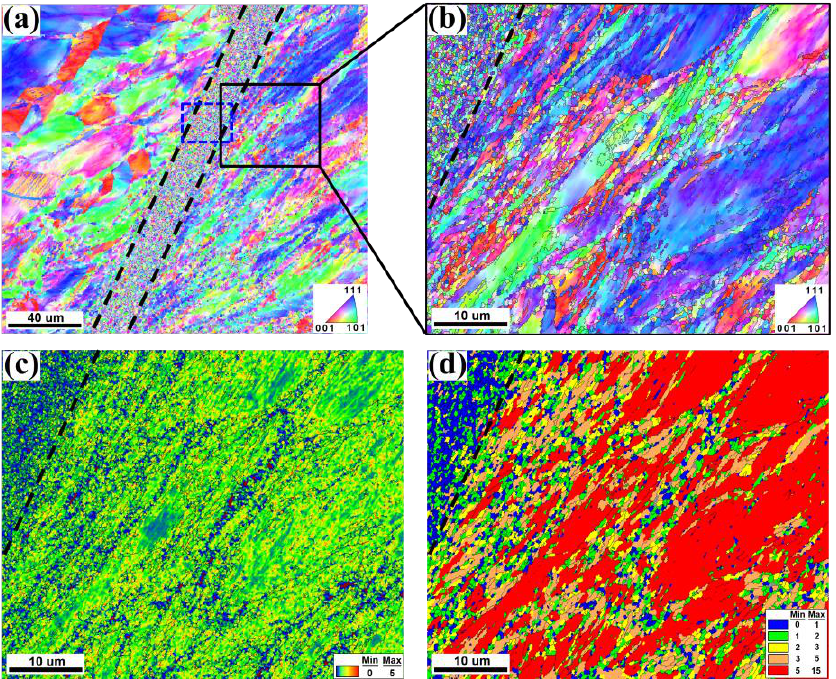
Figure 4. EBSD micrographs of the shear localization zone (step size: 150 nm): ( a ) IPF orientation map; ( b ) IPF orientation map of areas adjacent to the shear band; ( c ) KAM map of areas adjacent to the shear band; ( d ) GOS map of areas adjacent to the shear band.